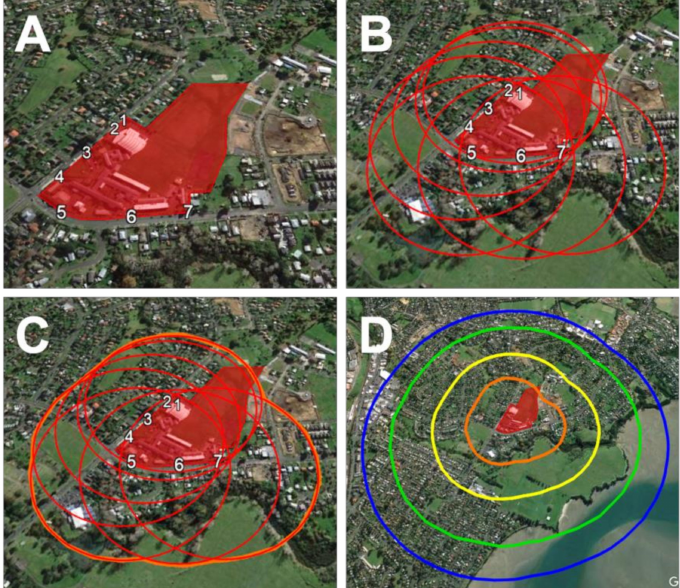
Figure 1. Preparation of the mapping area via Google Earth Pro, 2017; ( A ): school site and entries; ( B , C ): marking concentric intervals (250 m 500 m, 800 m, 1000 m) from entry points; ( D )—final radial zones used for